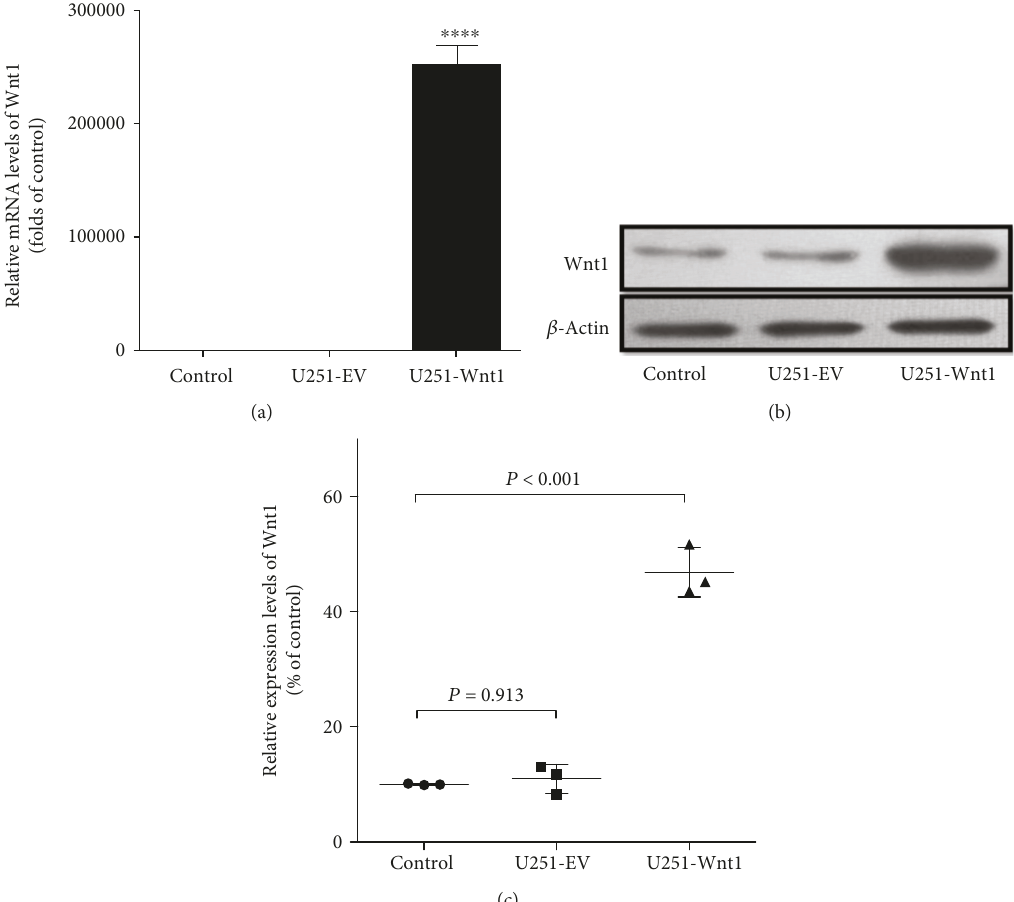
Figure 3: Evaluation of the Wnt1 overexpression vector in U251 cells by Western blot and PCR. Forty-eight hours after transfection with the Wnt1 expression vector or empty vector, U251 cells were harvested, and the mRNA and protein levels of Wnt1 were determined by real-time PCR and Western blot. The mRNA (a) and protein (b, c) levels of Wnt1 were signi fi cantly higher in U251 cells overexpressing Wnt1 than in control cells, whereas the empty vector did not in fl uence Wnt1 expression. ∗∗∗∗ P < 0 0001 . For Western blot assay, di ff erences among groups were examined by using ANOVA followed by Tukey-Kramer tests for post hoc multiple comparisons (c). F value = 161.42, df df = 6 , and df = 8 withingroups total